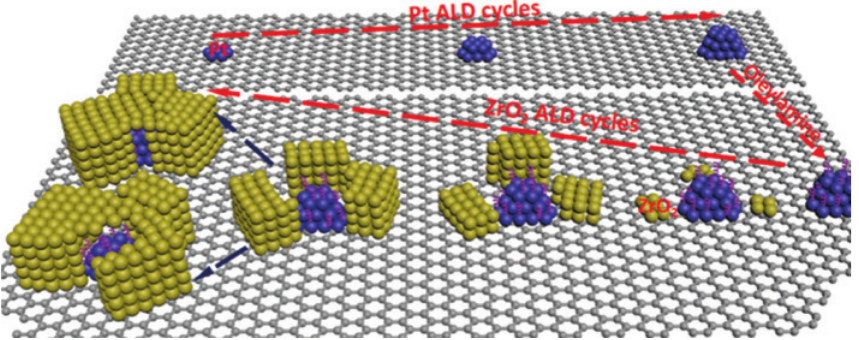
Figure 11: Schematic diagram of zirconia-encapsulated platinum nanocage structure fabricated by area-selective ALD. Reprinted with per- mission from Ref. [93]. Copyright 2014 John Wiley and